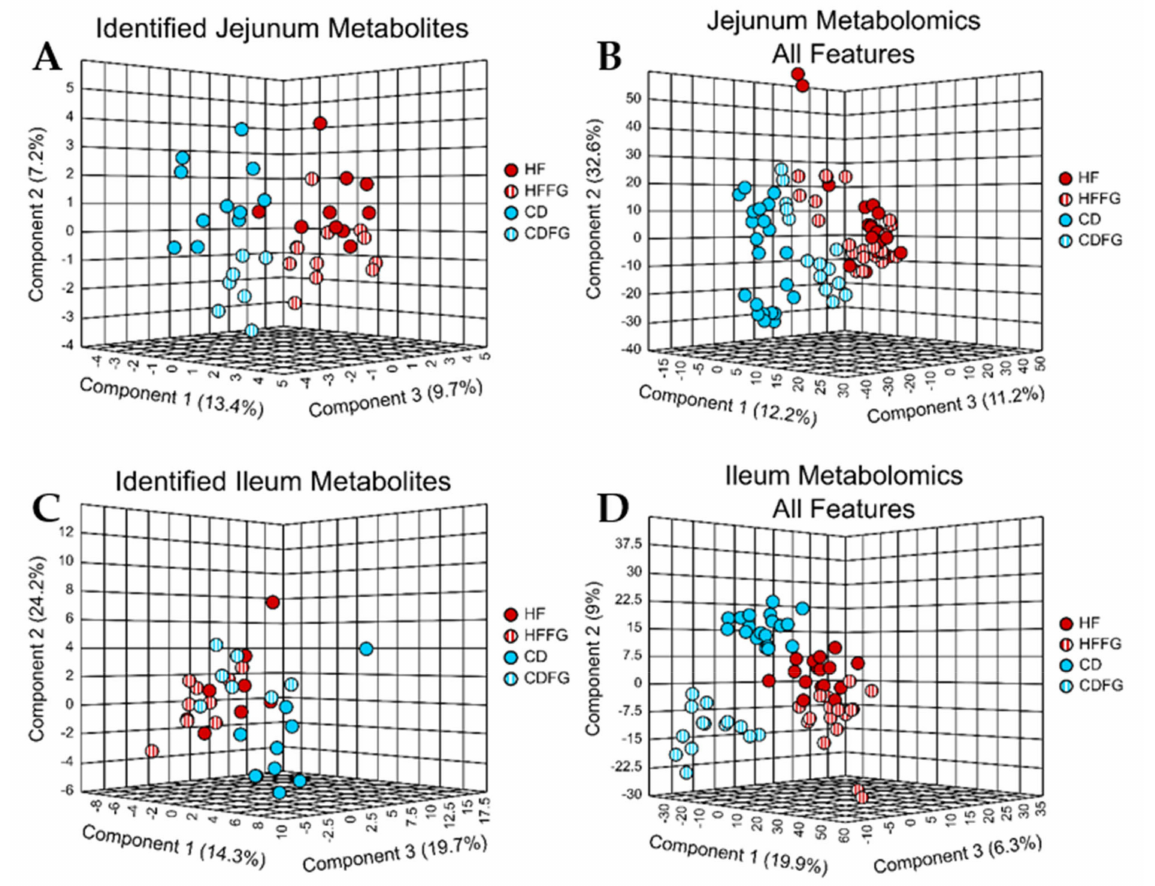
Figure 2. PLS-DA display minimal differences in metabolic profiles between diets and the respective FG supplemented diet in small intestines. Untargeted metabolomics was performed on the jejunum and ileum contents mice fed HF, HFFG, CD, or CDFFG diets for 14 weeks. PLS-DA were performed for ( A ) identified jejunum metabolites, ( B ) all jejunum spectral features, ( C ) identified ileum metabolites, and ( D ) all ileum spectral features. Cross validation values can be found in Supplementary Table S1. Experimental replicates are shown; HF samples are shown in red, HFFG samples are shown in red stripes, CD samples are shown in blue, and CDFG samples are shown in blue